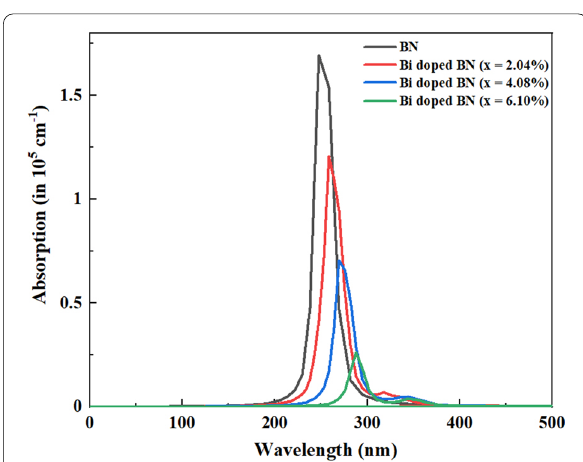
Fig. 6 The simulated optical absorption spectra of pure and Bi‑doped BN